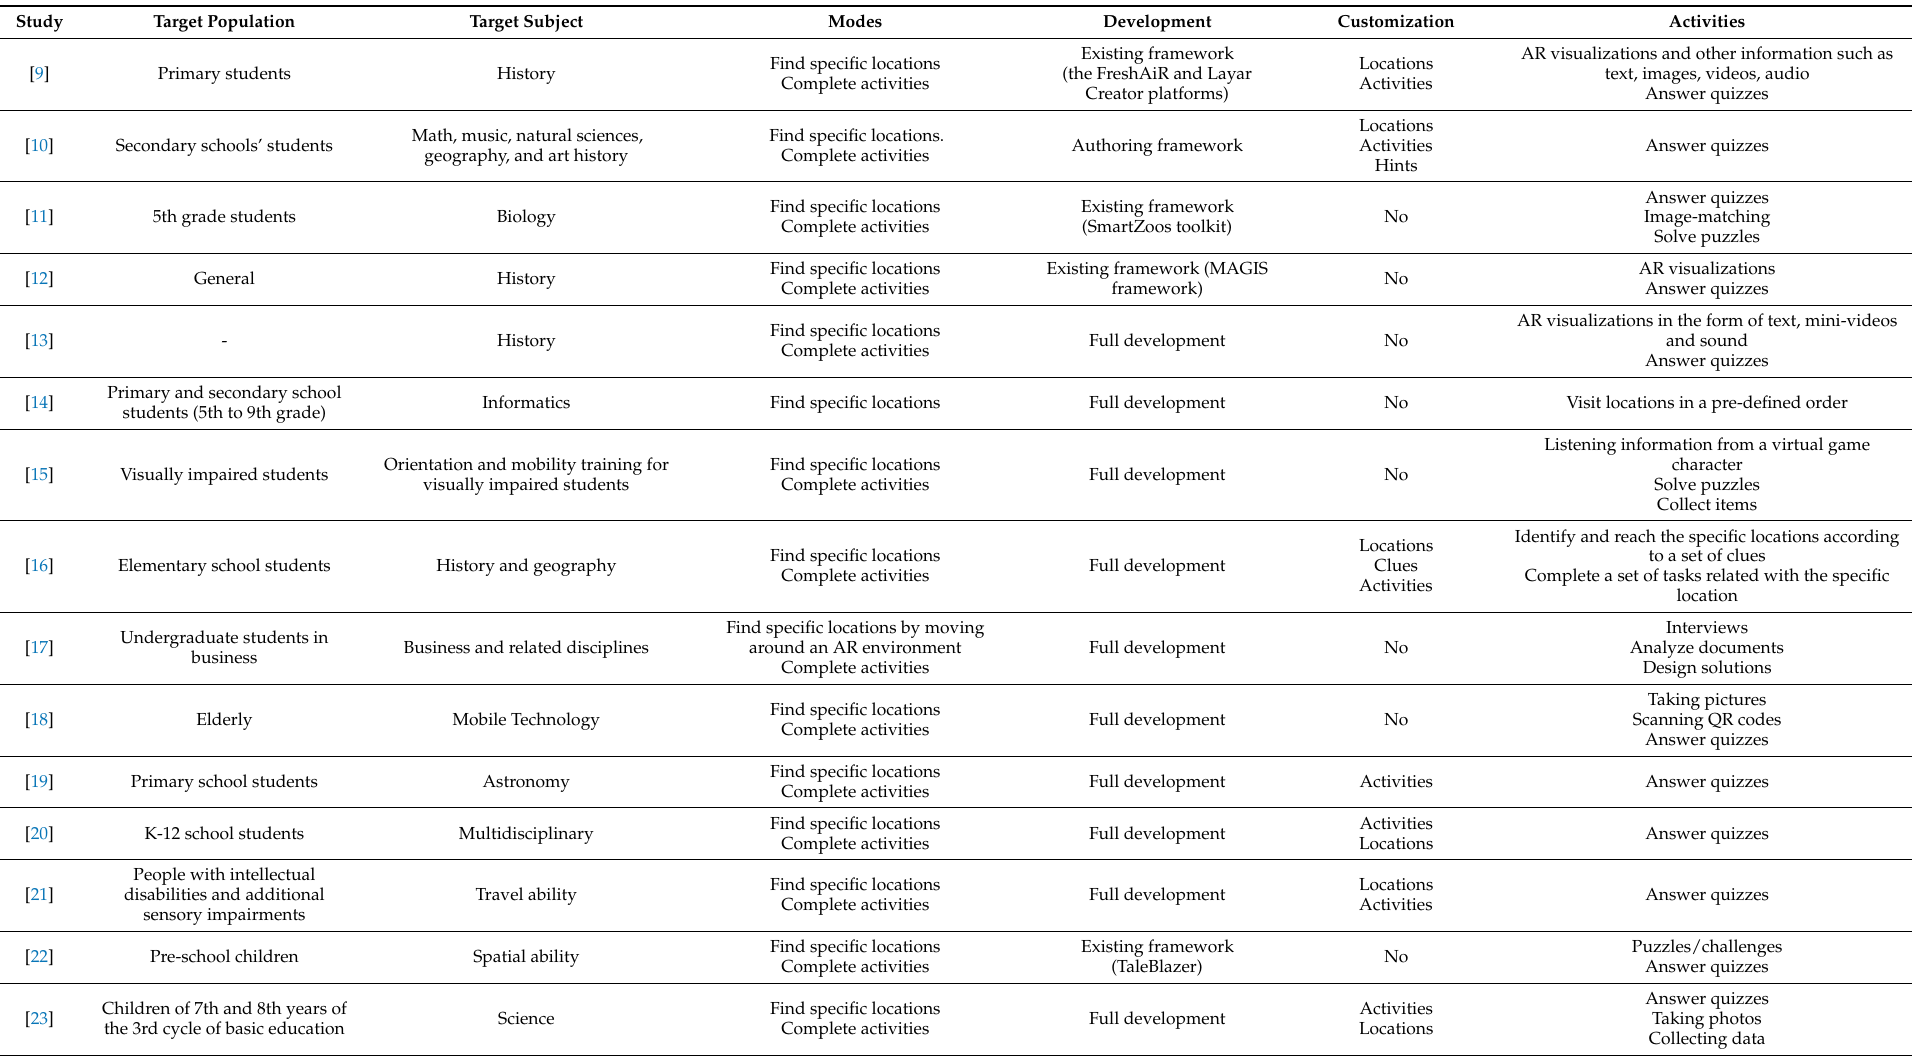
Table 4. Location-based games for education ( n =